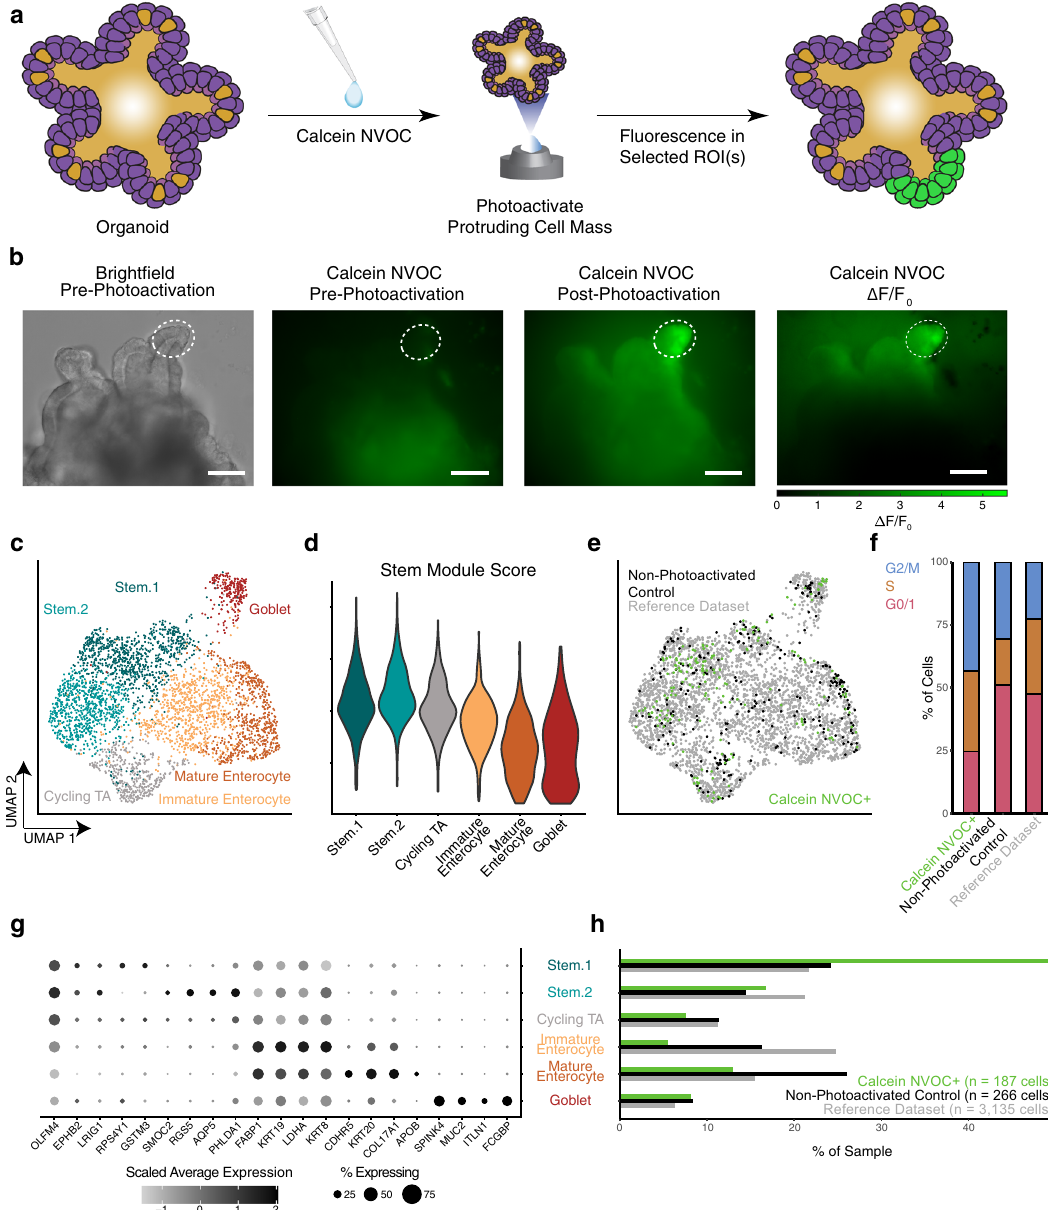
Fig. 2 Application of SPACECAT for physical isolation of stem cell niches from human small intestinal organoid models. a Schematic of organoid crypt selection with the SPACECAT protocol. Organoid graphic adapted with permission from ref. 67 . b Representative images of cultured organoids and example selected regions for photoactivation and selection, as well as changes in fl uorescence normalized to baseline fl uorescence. Dashed line: photoactivated region boundary; scale bar = 100 μ m. n = ~70 regions from the periphery of ~20 organoids, targeting 10 – 20 regions per protrusion. c UMAP of 3,588 single cells in total, from non-photoactivated control organoids ( n = 266 cells), sorted calcein NVOC + cells from photoactivated organoids ( n = 187 cells), and an internal reference dataset of organoids derived from the same patient and cultured identically (n = 3135 cells); cells colored by annotated cell type. d Scoring of cell types for expression of a module of stem-associated genes (LGR5, AXIN2, FZD7, OLFM4, LRIG1), following the approach of Tirosh et al. 68 . e UMAP of organoid dataset, colored by experimental condition (non-photoactivated controls: black; calcein NVOC + : green; reference dataset: gray). f Cell cycle stage by isolation condition as determined by gene module scoring (Tirosh et al. 68 ), p value < 0.001 when comparing Calcein NVOC + cells to either other cell population by Chi-square test (Calcein NVOC + : 187 cells, green; non-photoactivated control: 266 cells, black; reference dataset: 3,135 cells, gray; p value = 7.404 × 10 − 8 for calcein NVOC + vs. non-photoactivated control, p value = 3.436 × 10 − 12 for calcein NVOC + vs. reference). g Selected differentially expressed genes marking each cell type. Circle size denotes percentage of each cluster expressing a given gene, circle color denotes relative digital gene expression compared to other clusters. h Cluster membership by experimental condition, p value < 0.001 when comparing calcein NVOC + cells to either other cell population by Chi-square test ( p value = 3.587 × 10 − 8 for green vs. black, p value < 2.2 × 10 − 16 for green vs. gray). Source data are available as a Source data fi